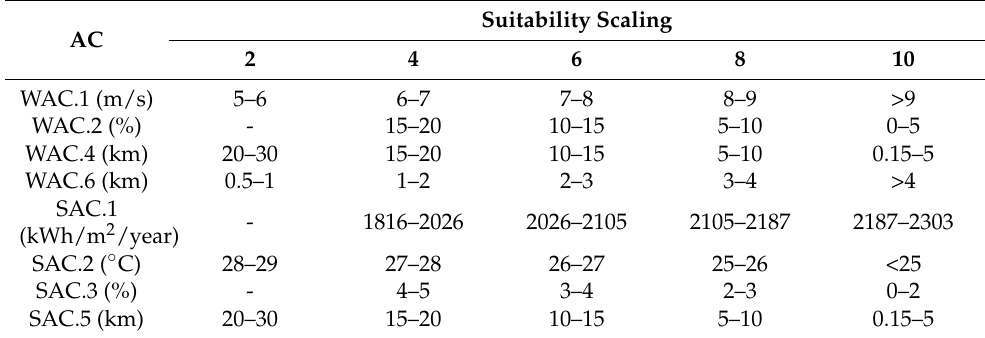
Table 4. Suitability scaling of essential Wind Assessment Criteria (WAC) and Solar Assessment Criteria (SAC).